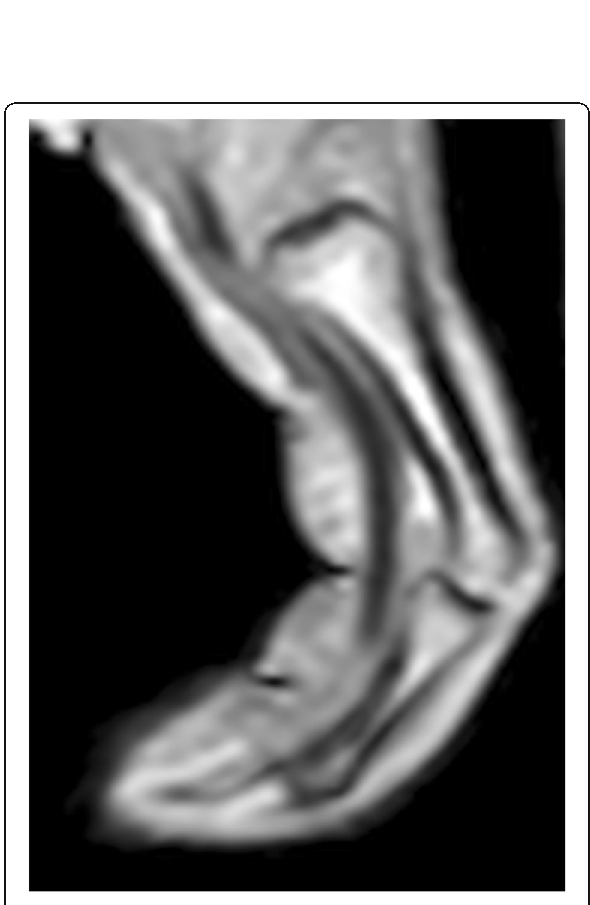
Fig. 4 Real-time dynamic MR image obtained with the UFGE sequence at 3.0 T. Finger in the sagittal plane in flexion (TR, 4.7; TE, 2.3; flip angle, 15°; pixel size, 1.09 × 1.46 mm)